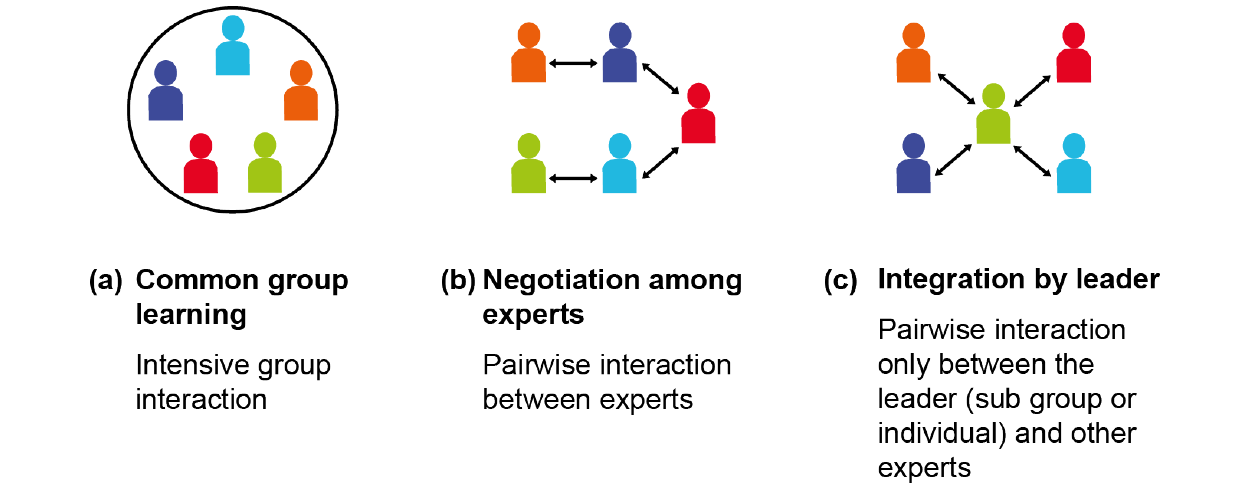
Fig. 1. Three types of procedure for generating synthesis, according to Rossini and Porter (1979). Colors represent different types of actor groups with differing roles and responsibilities in the synthesis